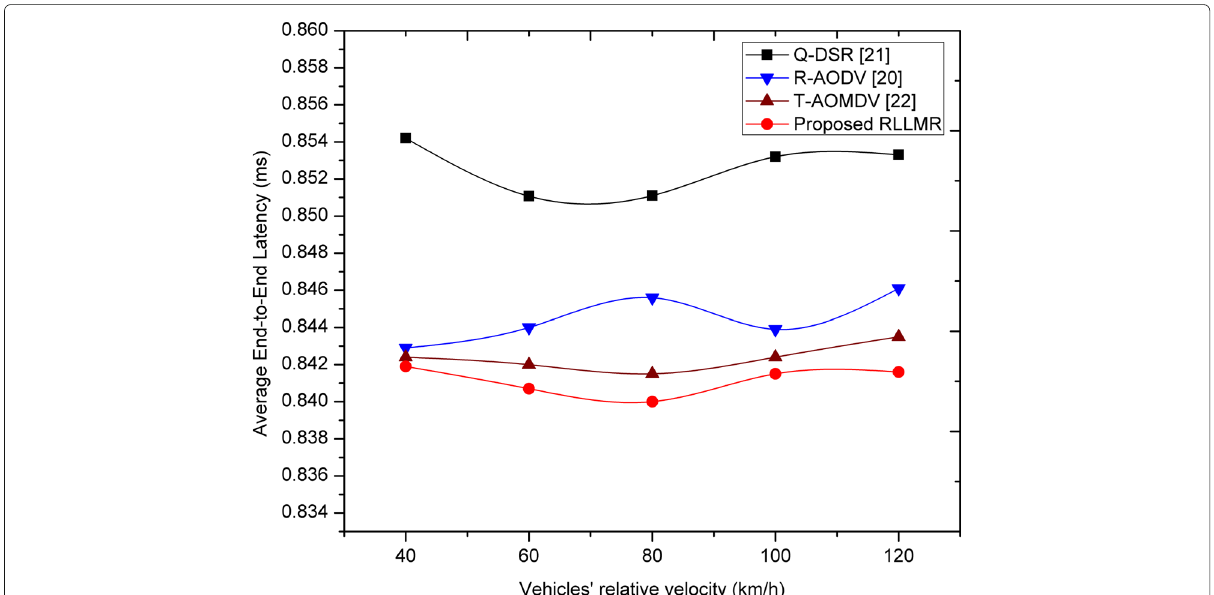
Fig. 15 Effect of different velocities over end-to-end latency (nodes 50, R 1000 m, sig 5 km/h, t 10 s)